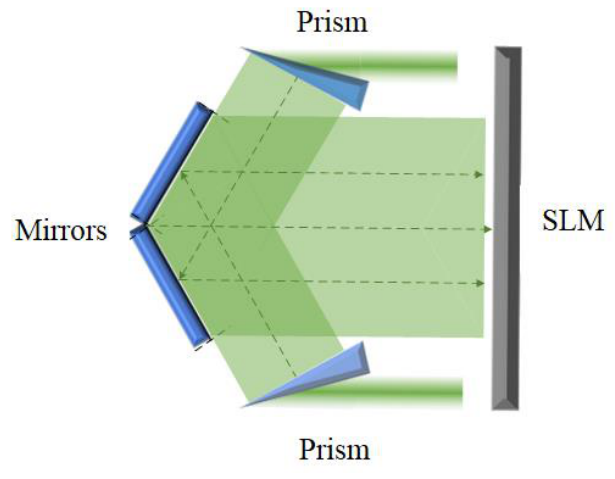
Figure 13. Principle and structure of the prism group.